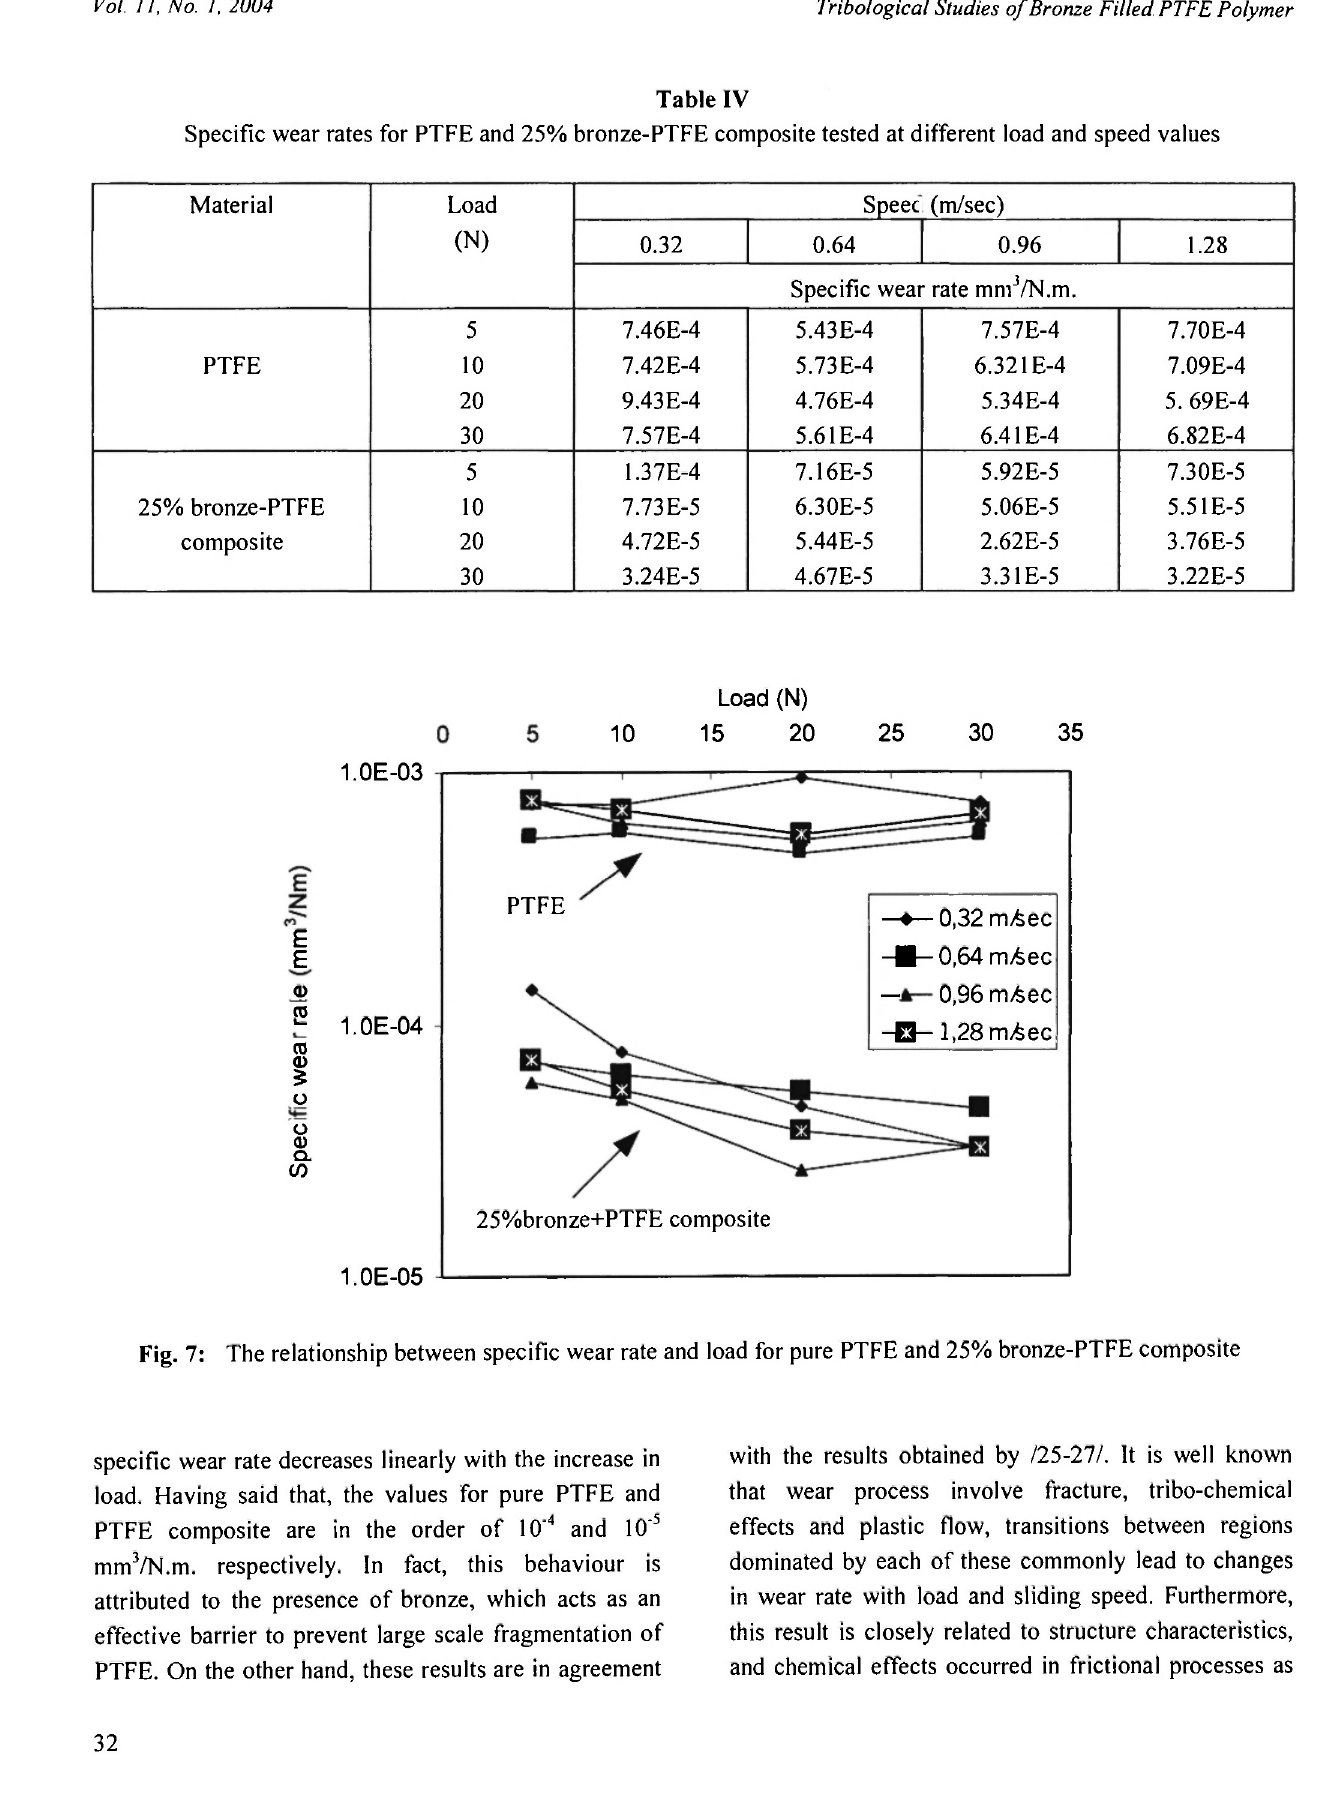
specific wear rate decreases linearly with the increase in load. Having said that, the values for pure PTFE and PTFE composite are in the order of 10" 4 and 10" 5